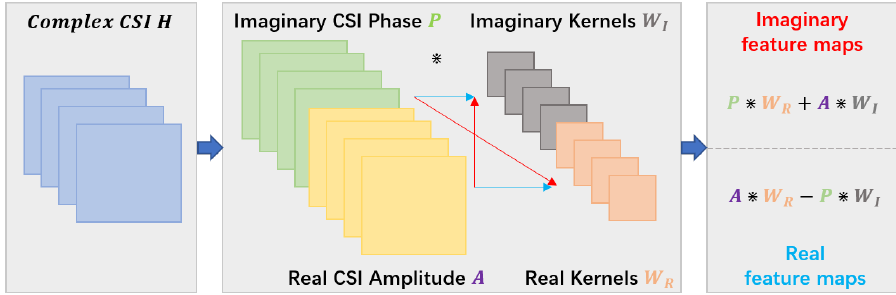
Figure 6. Complex convolution